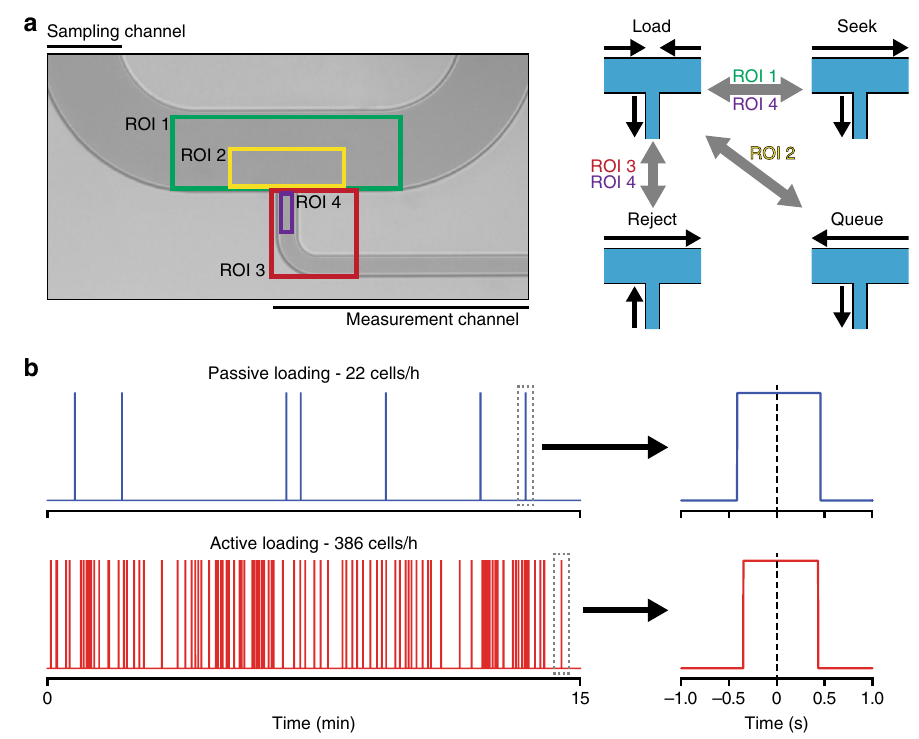
Fig. 1 Schematic of active loading by optically triggered fl uidic state switching. a Regions of interest (ROIs) are labeled as colored boxes. ROI 1 (green) is used to detect particles when in the “ seek ” state. Detection of a particle at traveling at a high fl ow rate in the sampling channel by ROI 1 causes a temporary change to the default “ load ” state, and reverts following entrance of a single particle into the measurement channel as detected by ROI 4 (purple). ROI 2 (yellow) maintains the presence of a single particle in the sampling channel for the next loading duty cycle. As a single particle is detected by ROI 2 while in the “ load ” state it triggers adoption of a “ queue ” state, which bumps the cell back in the sampling channel before reverting to the “ load ” state. This continues until the duty cycle is complete. ROI 4 (purple) and ROI 3 (red) work together to detect entrance into the measurement channel and the presence of debris or doublet events, respectively. Once ROI 4 detects entrance of a particle in the “ load ” state, ROI 3 quickly images the event, switching to the “ reject ” state if the particles geometry or contrast is outside previously set parameters de fi ning an unwanted particle. b Comparison between passive throughput (22 cells h − 1 , 95% CI: 13, 39, n = 9) and active loading (386 cells h − 1 , 95% CI: 354, 433, n = 247) for murine L1210 cells (50 μ L − 1 ) fl owing through a transit time detector in the measurement channel (Supplementary Fig. 1, see Methods). Zoom-in plots show passage of a single cell with